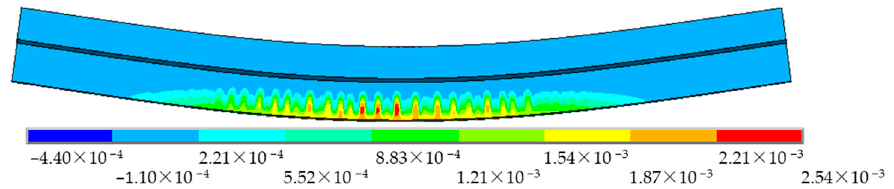
Figure 13. Contour plots of the plastic strain of the